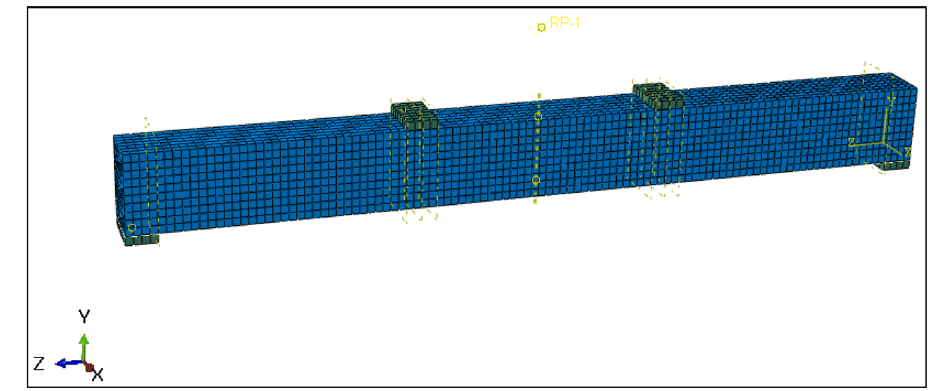
Figure 4: Meshing of beam.